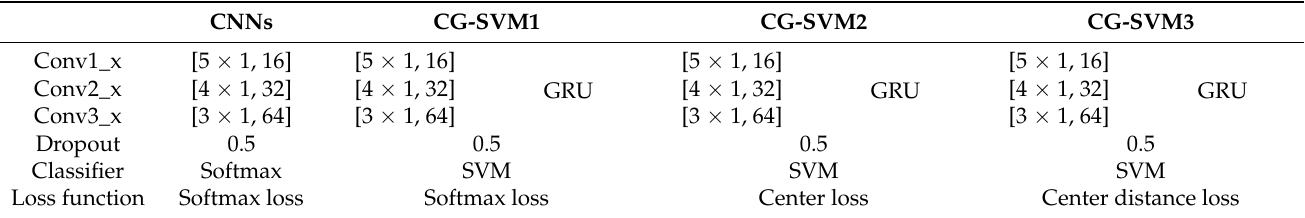
Table 3. Detailed parameters of each network